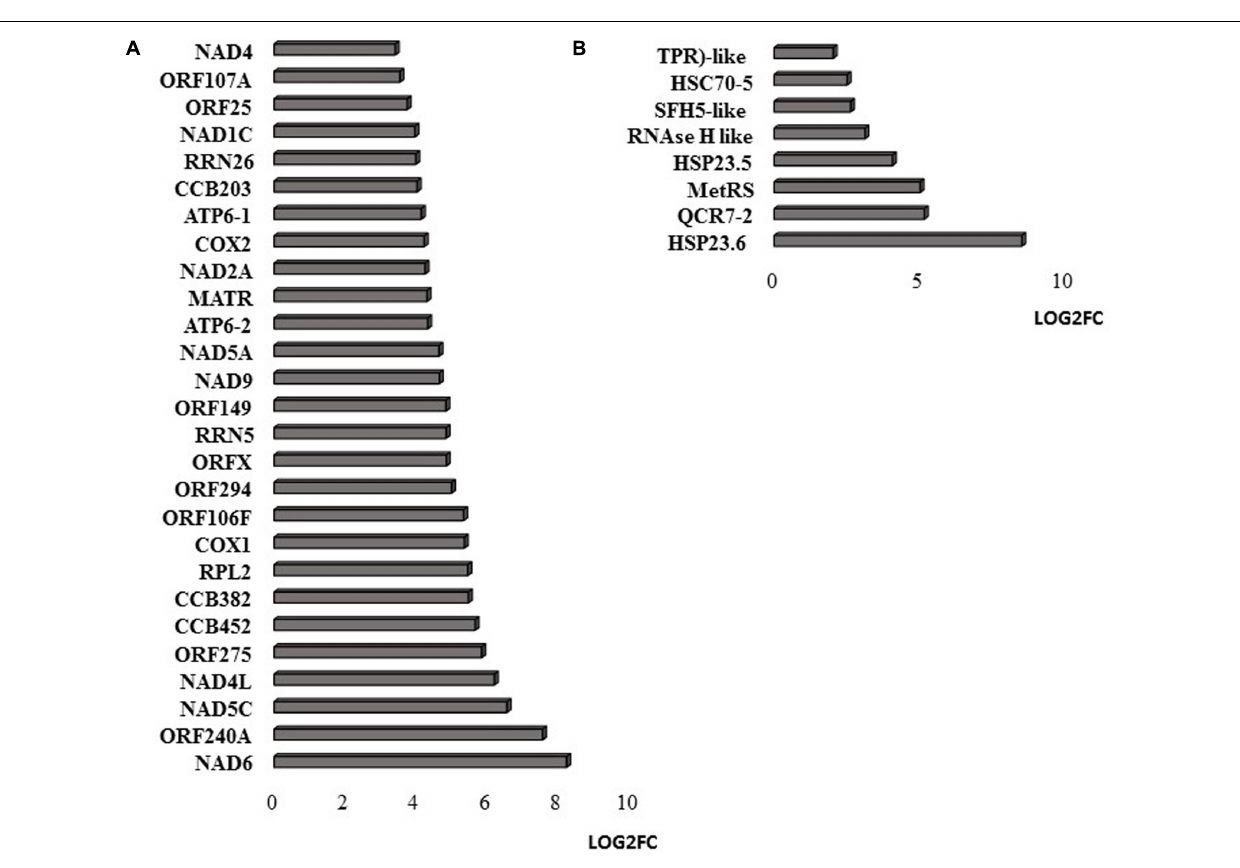
FIGURE 7 | Mitochondrial-encoded transcripts (A) and nuclear-encoded transcripts targeted to mitochondria (B) . The abundance is expressed as relative expression of (log2) fold change (LOG2FC) with an FPKM > 1 and FDR-corrected p- value of 0.05 or less. NAD6 (ATMG00285), ORF240A (ATMG00382),